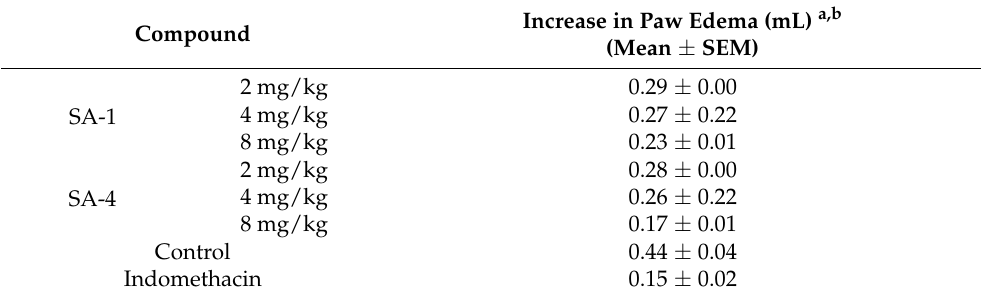
Table 4. In vivo anti-inflammatory activity of compounds using carrageenan-induced rat paw edema method.